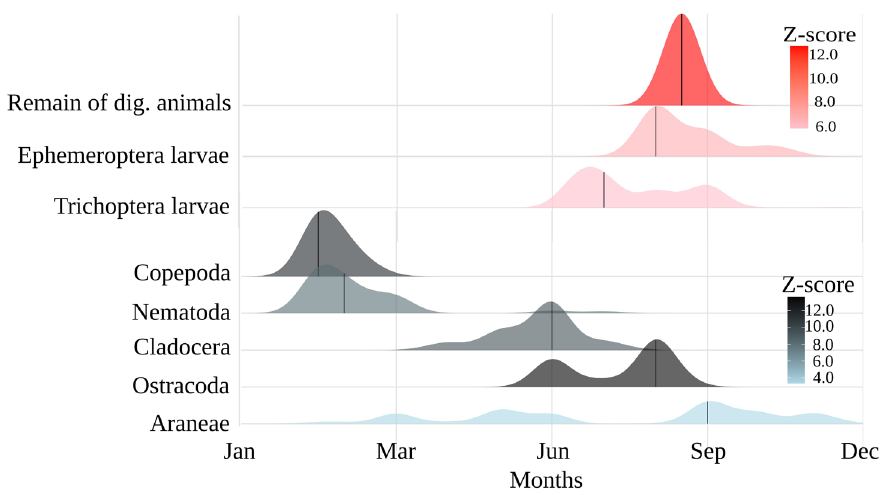
Figure 4. Variation of Eigenmannia desantanai food items over the months based on Threshold Indicator Taxa Analysis. The higher the value of the Z-score, the better the indication of the item.